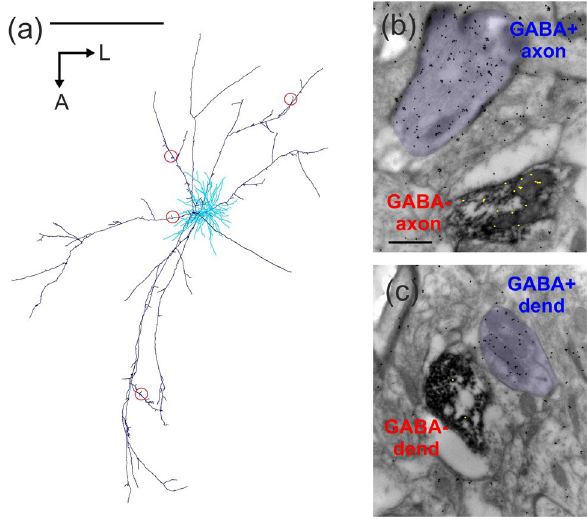
Figure 5. ( a ) Red circles show 4 regions of the L6SC axon (dark blue) which were subjected to EM analysis. The dendritic field is marked in light blue (drawing was created using the software package Neurolucida (v.8.26, MBF Bioscience, https:// www. mbfbi oscie nce. com). Exemplary images show postembedding GABA- immunostaining of an axon segment ( b ) and a dendrite ( c ). In ( b ) the DAB labelled L6SC axon shows GABA- immunonegative reaction (the 17 gold nanoparticles were substituted with 17 yellow dots for better visibility) while the other axon of unknown origin (purple) is GABA-immunopositive as represented by the nearly 5 times higher density of gold particles above the axoplasm. ( c ) DAB labelled dendrite of L6SC which showed GABA immunonegativity while the other dendrite (purple shade) of unknown origin was immuno-positive to GABA. Scale bars ( a ): 1 mm, ( b , c ): 0.5